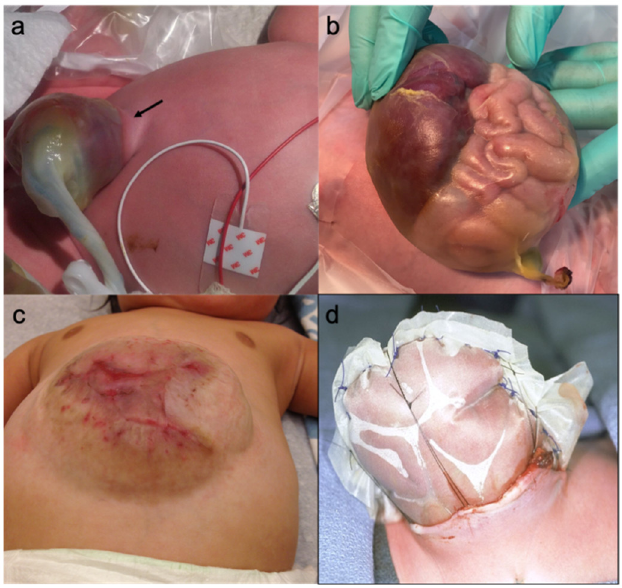
Figure 2. ( a ) Hernia into the cord (arrow pointing at the skin cuff); ( b ) Giant omphalocele with herniated liver and intestine; ( c ) Large abdominal wall hernia after paint and wait; ( d ) Schuster